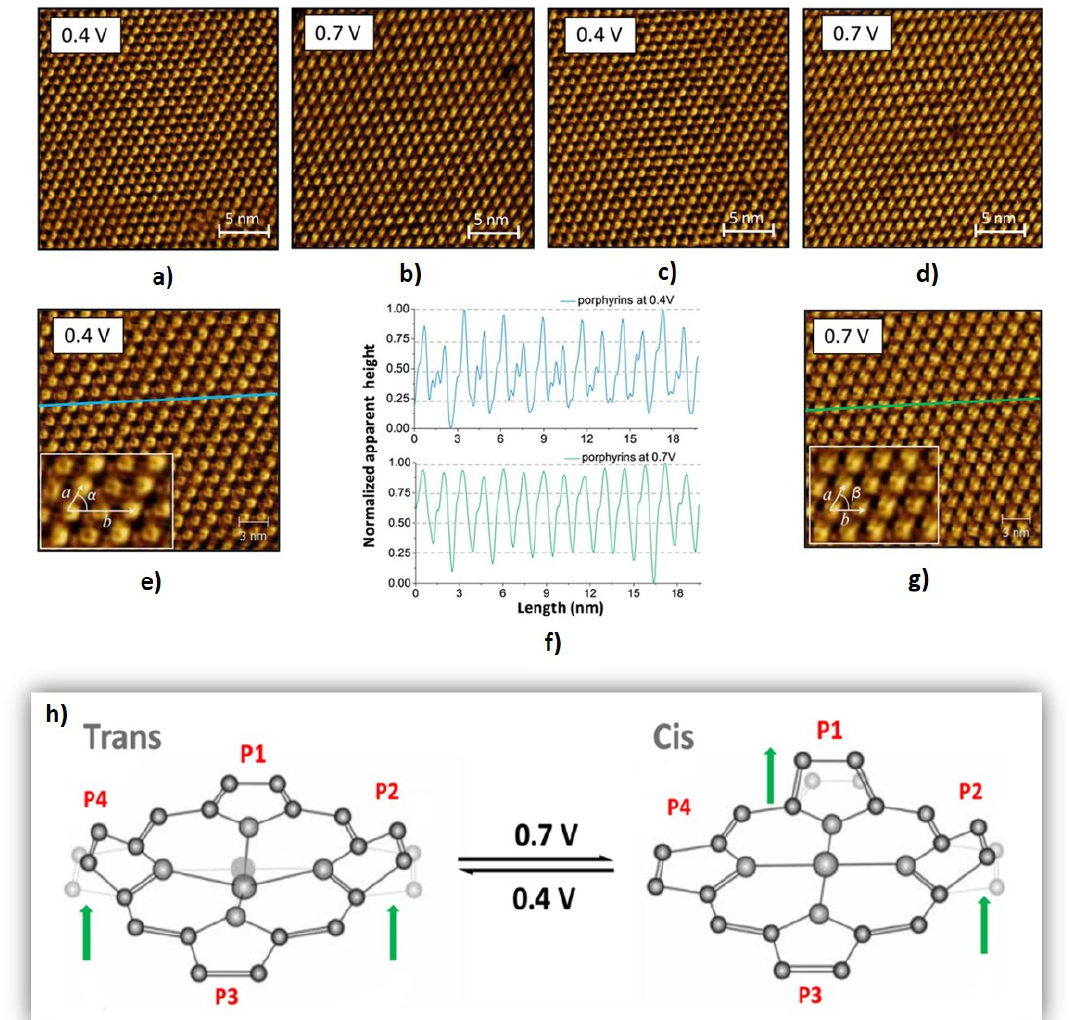
Figure 7. ( a – d ) Sequential STM images of ZnOEP monolayer at the tetradecane/HOPG interface revealing conformational changes upon application of stimuli. ( e ) the blue line and ( g ) the green line acquired from the STM images are represented ( f ) by profile lines in normalized apparent height maps indicating the differences between heights in accordance with different molecular conformations. ( h ) Reversible switch able mechanism of ZnOEP molecules representing the Trans and Cis conformations. The pyrrole groups indicated by P1, P2, P3, and P4 adopt different positions in relation on the plane of the macrocycle. The green arrows indicate the pyrrole groups which are turned up. (Reprinted with permission from reference [65]. Copyright 2018 The authors and Royal Microscopical